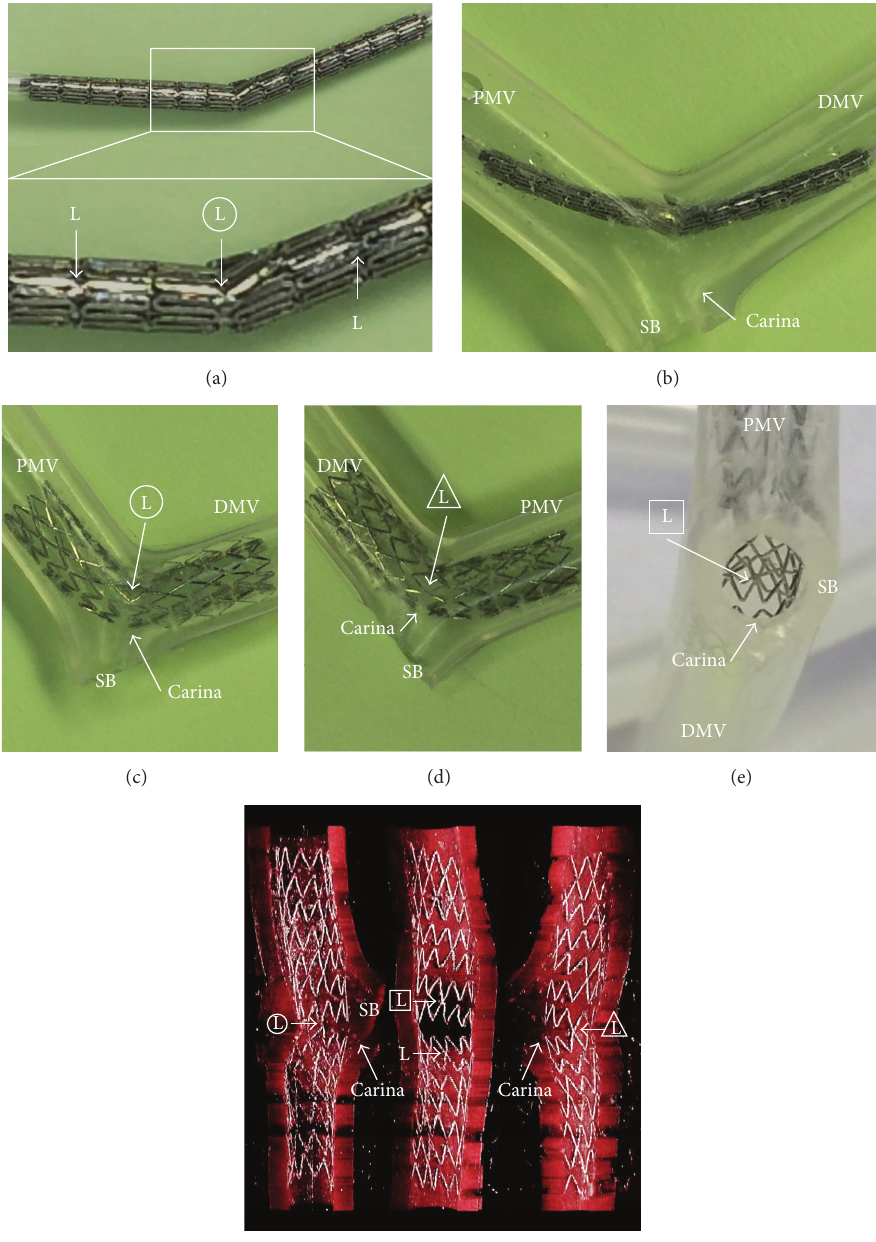
Figure 1: Bent stent technique in phantom study. (a) 3.5 × 18 mm two-link Biolimus-eluting stent (BES) is bent at the center articulation with laterally positioned links. (b) Bent position of this BES is matched to the carina of a phantom bifurcation vessel. After this BES is deployed, lateral view (c), opposite lateral view (d), side branch (SB) ostium from outside (e), and instant stent-accentuated three-dimensional optical coherencetomography(f)showfreecarinatype.PMV:proximalmainvessel;DMV:distalmainvessel;L:link.“Ls”enclosedbycircle,triangle, or square indicate the same links,